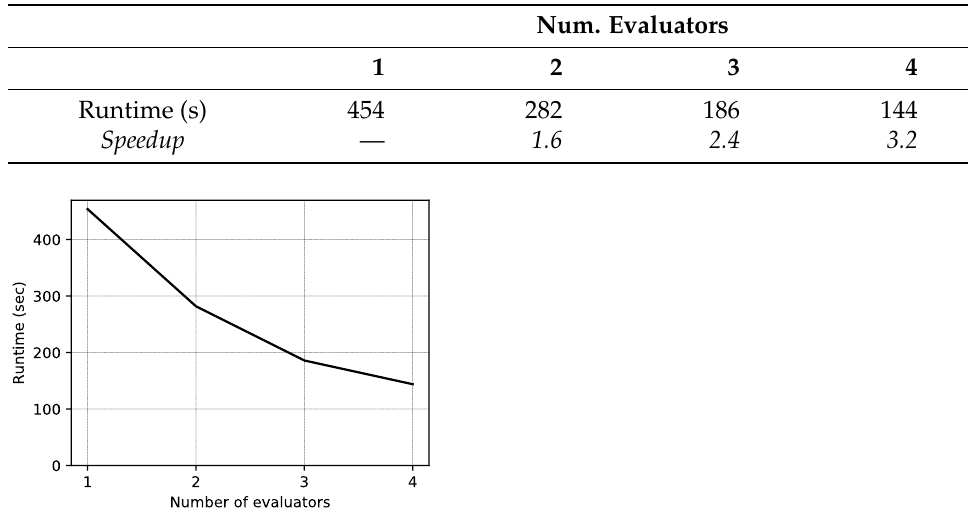
Table 3. Efficiency of the upper level of parallelization.